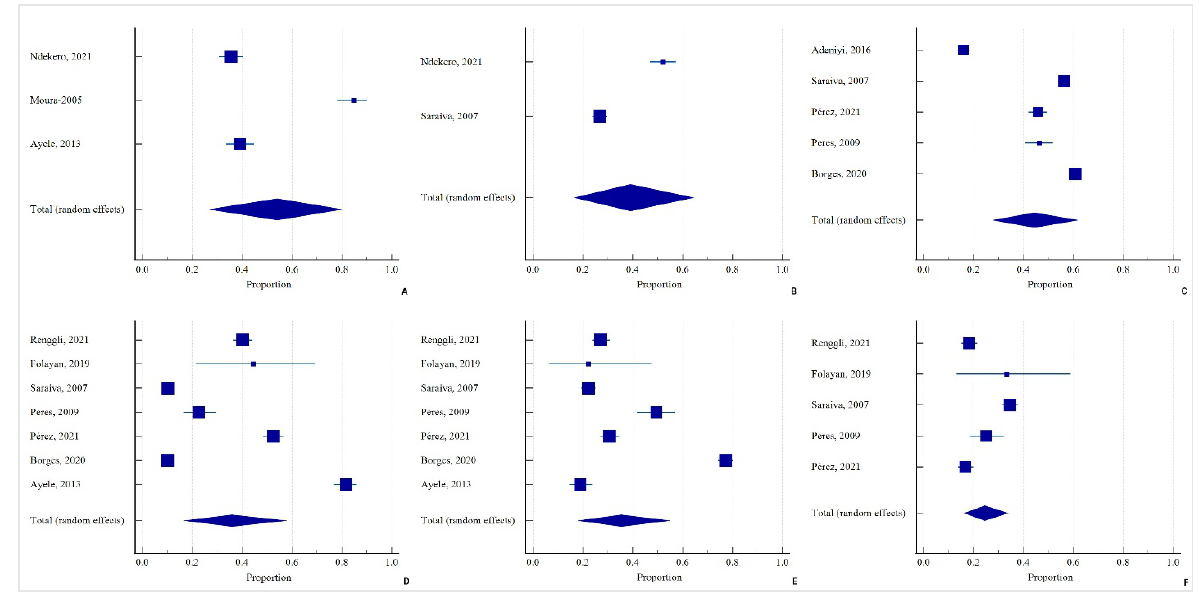
Figure 4. ( A ) Pooled prevalence of caregivers (i.e., mother) helping children with tooth brushing (n = 381/830) in the population with caries; ( B ) Pooled prevalence of children with caries using fluoride toothpaste (n = 438/1279); ( C ) Pooled prevalence of accessed and visited dental services in both groups (n= 2758/5629); ( D – F ) Pooled prevalence of low (n = 1040/3450), middle (n = 1338/3450), and high (n = 578/3450) socioeconomic status of the children/their families in the caries group, presented in a forest plot, applying the random-effects model.